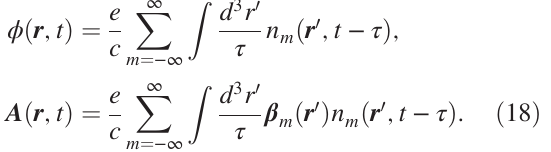
FIG. 1. Parallel plates located at y ¼ (cid:3) 1 the mid-plane shown in black. The coordinate system is chosen so that the orbit lies in the xz plane and the z -axis is directed along the tangent vector to the trajectory at x ¼ z ¼ 0